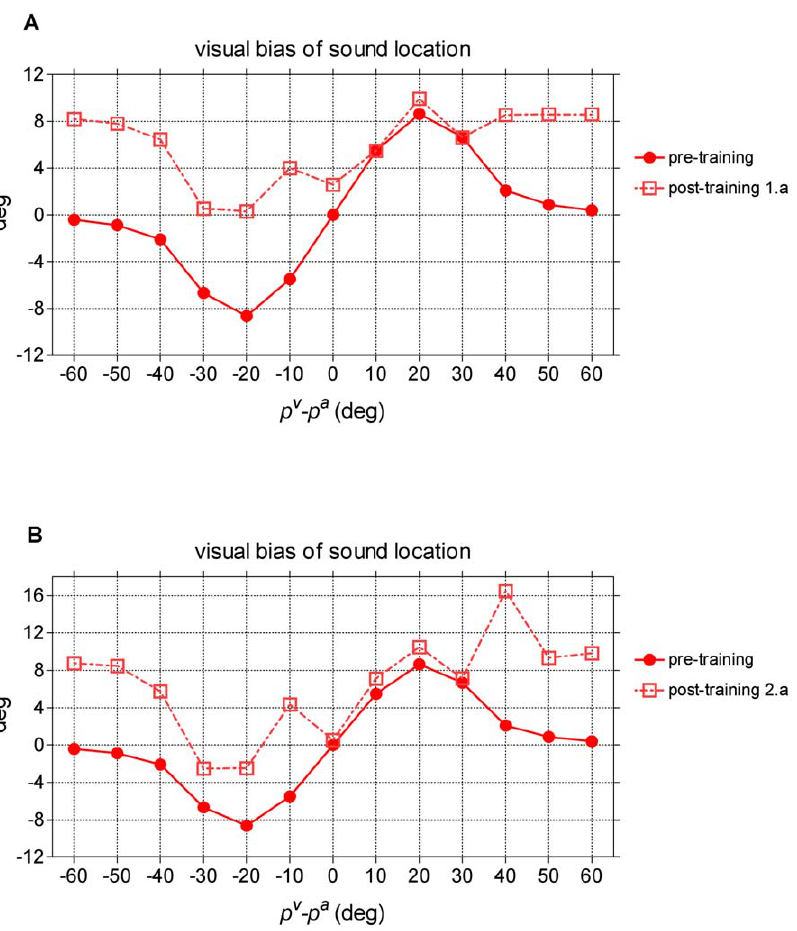
Figure 8. Visual bias of sound location after training. ( A ) Visual bias of sound location predicted by the model after training paradigm 1.a. The auditory stimulus was maintained fixed at position 100 u (the position used during training), while the visual stimulus was located at different positions from 40 u to 160 u (visual-auditory angular separation ranging from 2 60 u to 60 u ). The shift in sound location, computed in steady-state conditions, is displayed as a function of the visual-auditory angular separation. For the sake of comparison, results obtained before training are displayed too. ( B ) Visual bias of sound location predicted by the model after training paradigm 2.a. The same audio-visual stimulation as in panel A was performed, to compute the sound shift for different audio-visual disparities. The meaning of the symbols was the same as in panel A. Since training paradigm 2 involved all the acoustic space, the results displayed in the figure remain substantially unaltered for any position of the auditory stimulus.